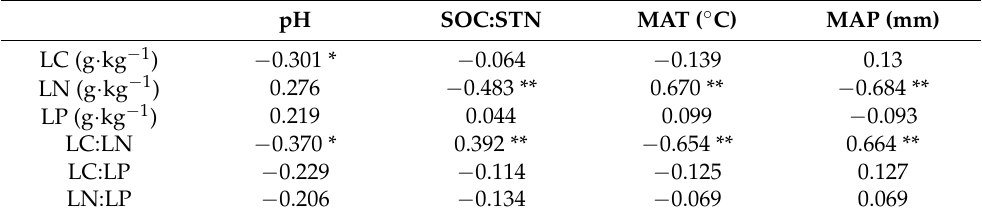
Table 4. The Pearson correlations between the dominant factors from the RDA and leaf stoichiometry of P. crassifolia